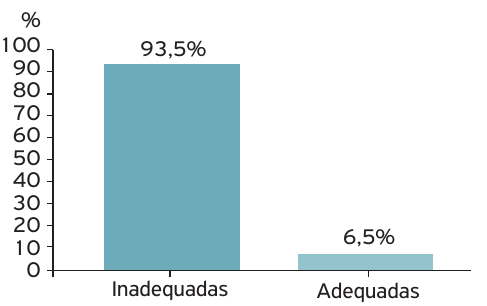
Figura 1. Adequação geral das amostras analisadas ao Ofício Circular Conjunto DFIP/DSA nº 1/2008